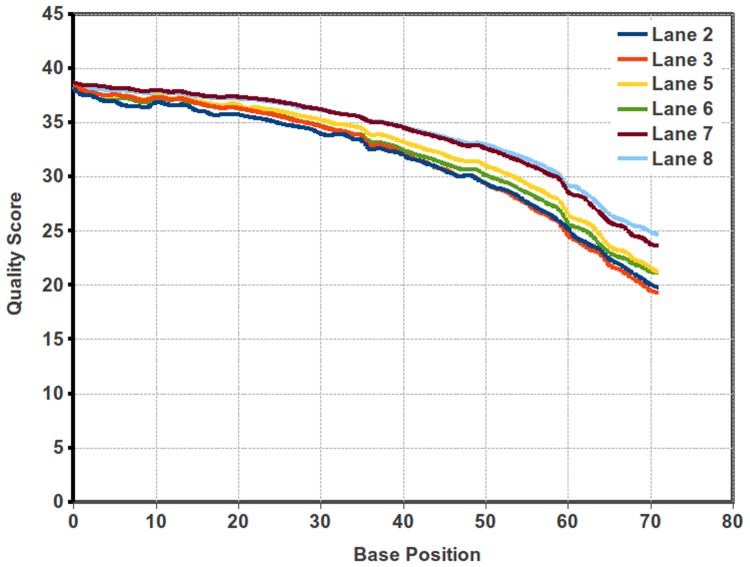
Quality score for each lane of Illumina reads.The line diagram of the quality score of the reads obtained from different lanes.